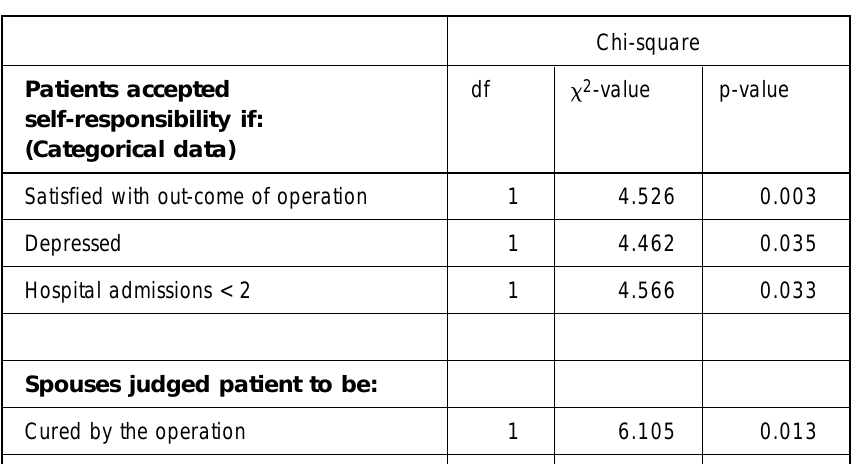
Table V111: Self-Responsibility - Twelve months after